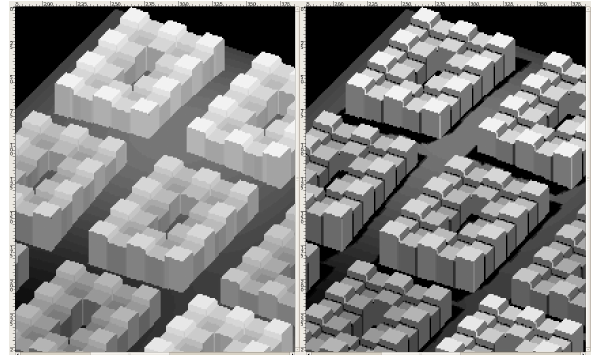
Figure 5: Synthetical DSMs, detail of occluded urban area DSM in 3D view, left DSM, right DSM with occlusions (elevation 60 ◦ )